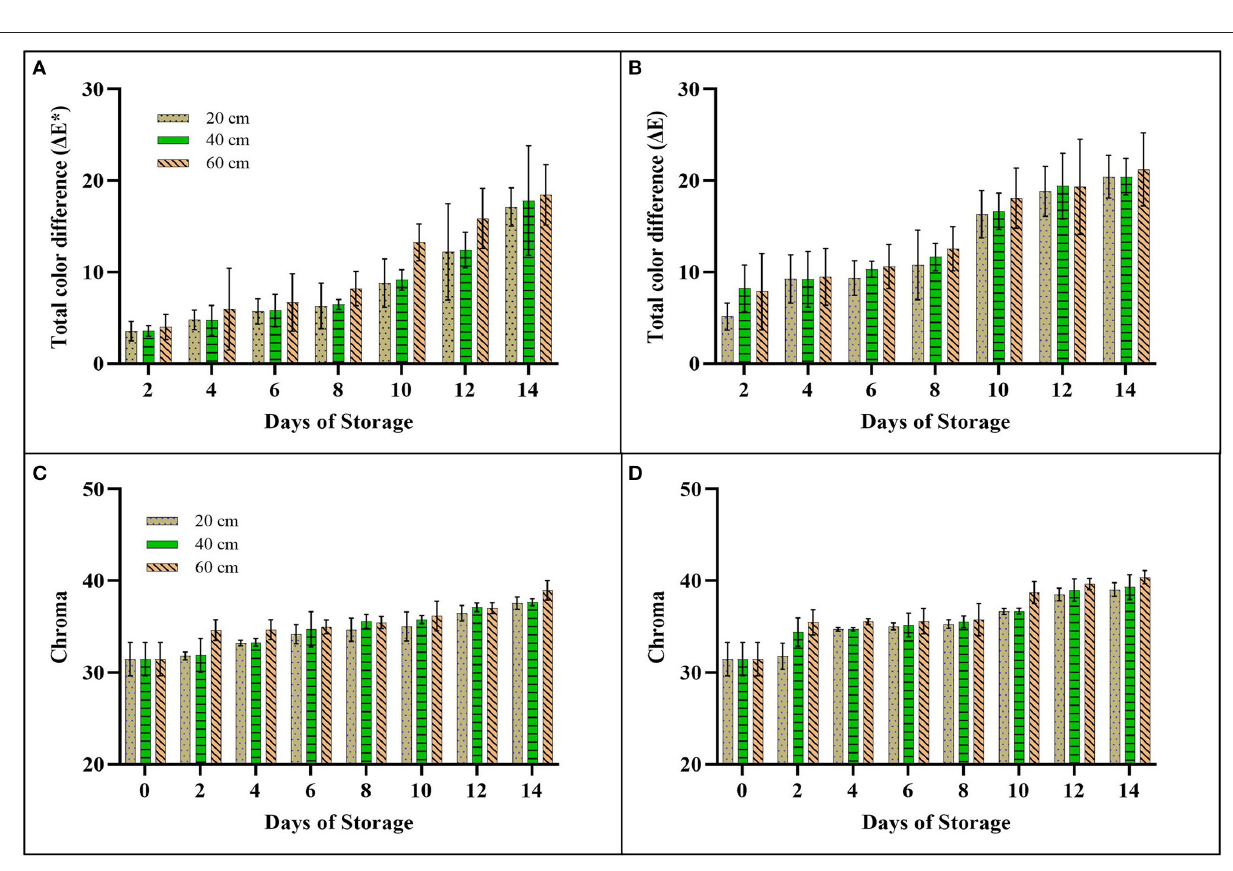
FIGURE 9 | Total color change ( 1 E*) and chroma of pear impacted at different drop heights (20, 40, and 60cm) during 14 days at (A,C) 10 ◦ C and (B,D) 22 ◦ C storage conditions. The data were expressed in mean ± standard deviation. Error bars represent the standard deviation (S.D.) of the mean values ± S.D. of 18 readings per three